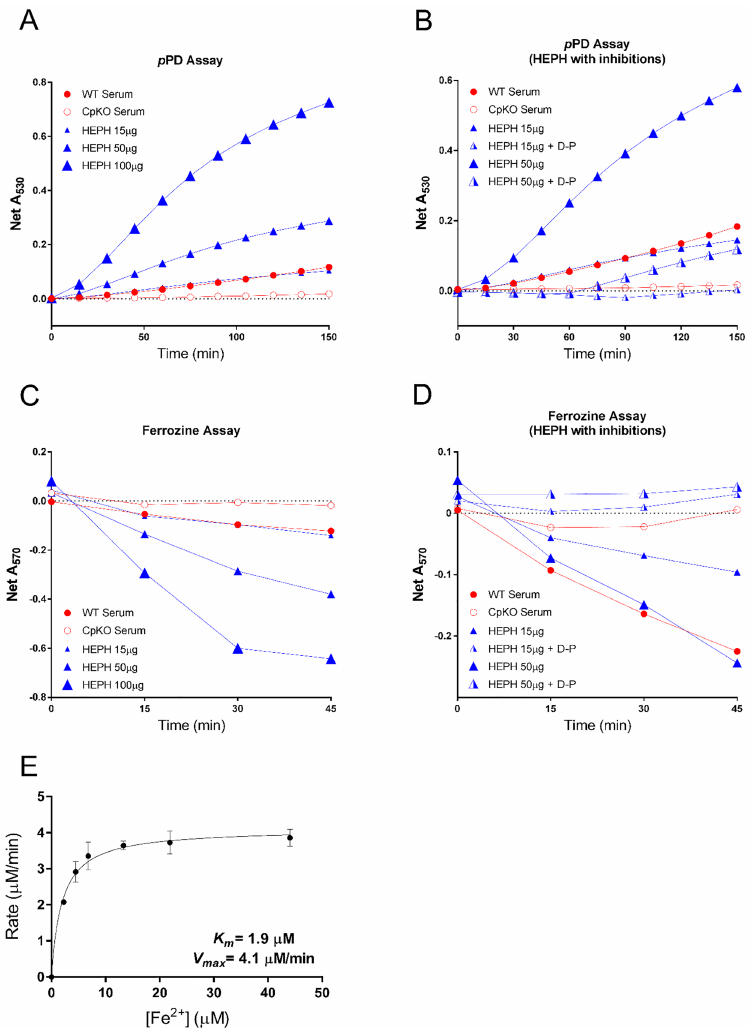
Fig 3. Oxidase activity of mouse HEPH. In all assays WT mouse serum and serum from a mouse CpKO were used as control. Details can be found in the main text. A , An oxidaseassay monitoringthe oxidationof p PD (increaseof A 530 ). The rate of HEPH catalysed oxidationreaction increasedwith an increasing protein concentration. B , p PD oxidationby HEPH was inhibitedby the copper-specific chelator D-penicillamine (D-P). C , A ferrozine-based assay was also used to follow the oxidationof Fe 2+ to Fe 3+ by HEPH (monitoredas a decreaseof A 570 ). Similarly to the p PD assay, an increasedcatalytic activity can be observedwith an increasing amount of HEPH present. D , The catalytic activity was, as in the pPD assay, inhibited by additionof D-P. E , A velocity versus substrate concentration curve used to obtain K m and V max for HEPH. Error bars represents 1 S.D, N = 3.